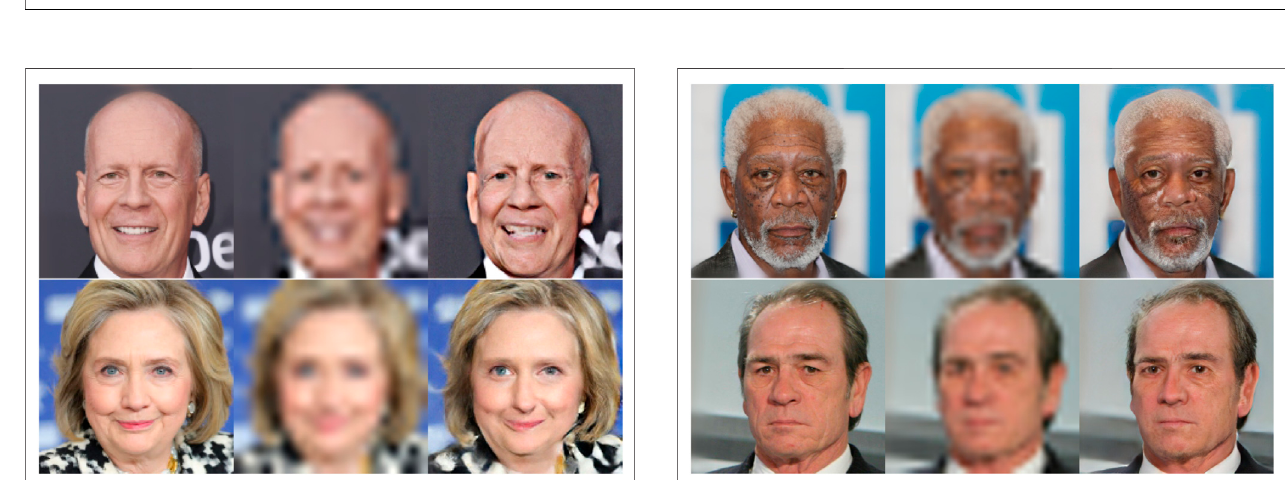
FIGURE 9 | Comparison of Bruce Willis ’ and Hillary Clinton ’ s faces. The original HR image is shown on the left (downscaled to 160 × 160), the bicubic interpolated version of the LR image is shown at the center, while the SRFlow super resolution version is shown on the right. For Bruce Willis, the measured gain coef fi cient was +0.32, while for Hillary Clinton it was − 0.25.